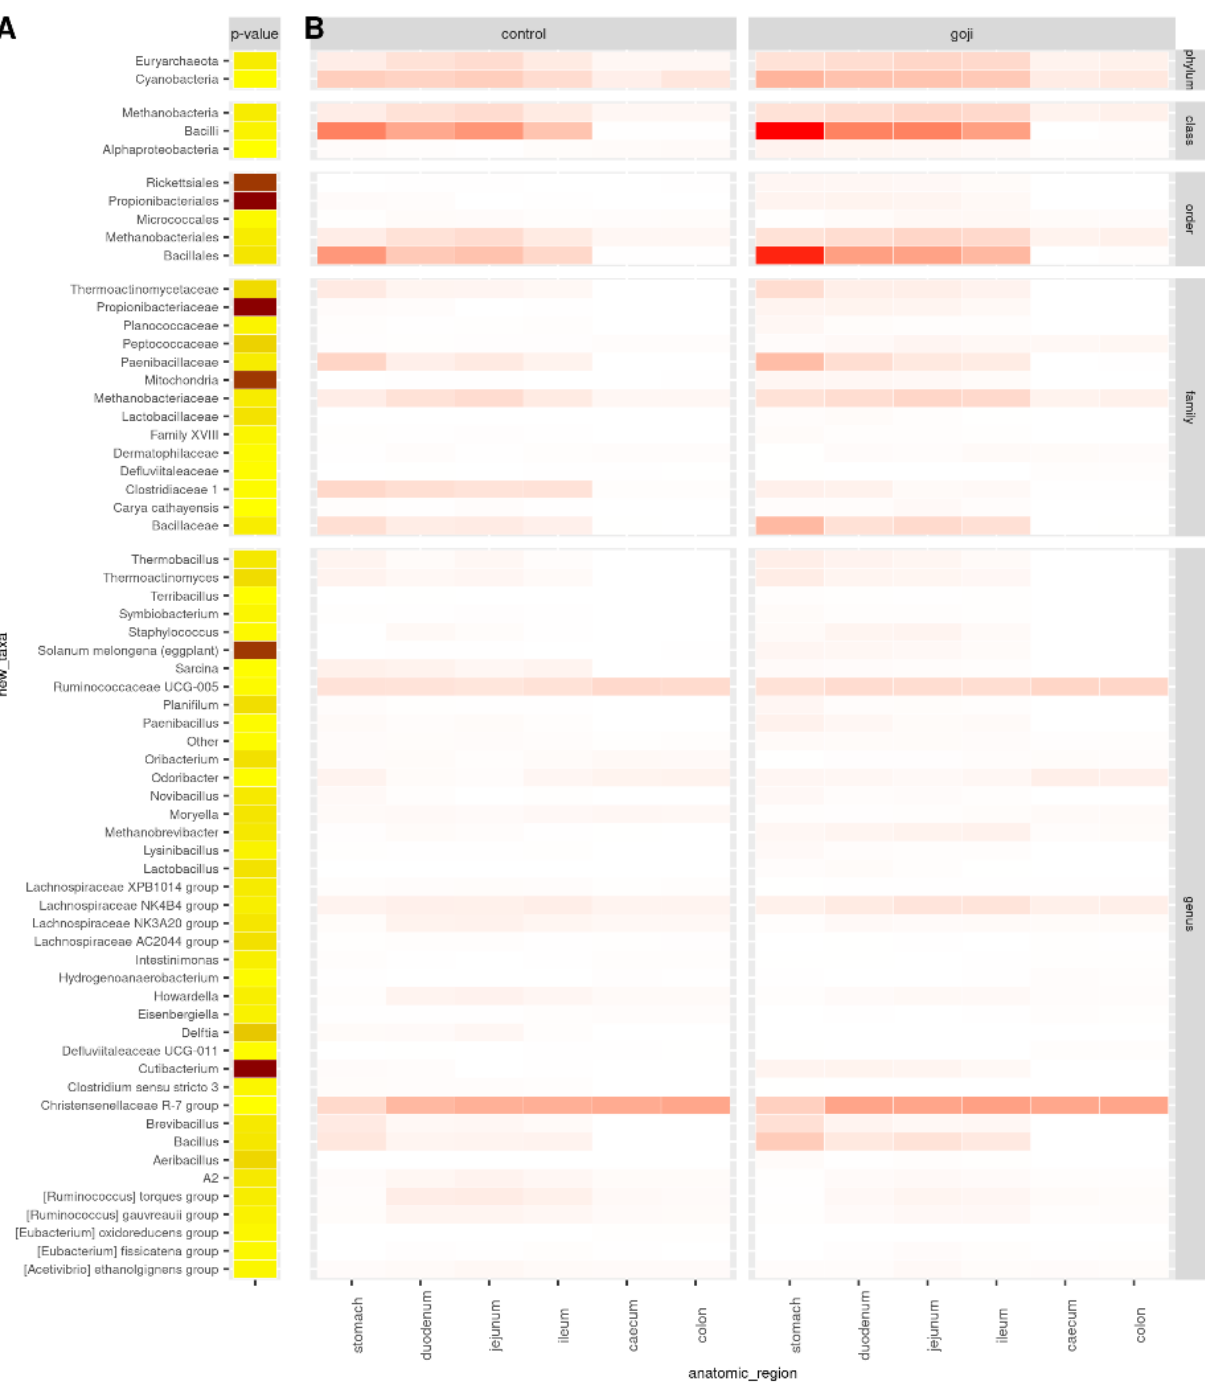
Figure 3. Significantly different OTUs. OTU significantly different between treatments from analysis of variance based on normalized counts: p -values ( A ) and counts per group and anatomic region of the rabbit digestive tract ( B ). p -value < 0.05 was used as cut-off. Darker colours indicate lower p -values ( A ) or higher counts ( B ). p -values are in the range 10 − 15 – 0.049, from dark brown to light yellow. For the analyses, 14 and 13 samples were used for the control and Goji groups, respec- tively.